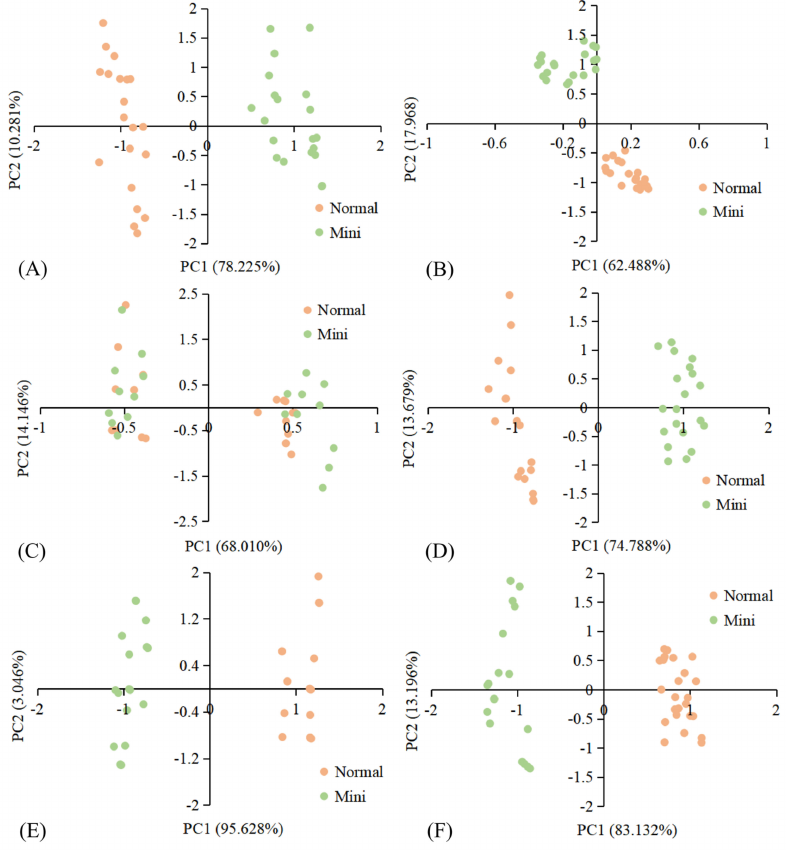
Figure 6. E-nose PCA score charts of MFV and NFV: ( A ) watermelon; ( B ) pineapple; ( C ) pumpkin; ( D ) cabbage; ( E ) maize; ( F )